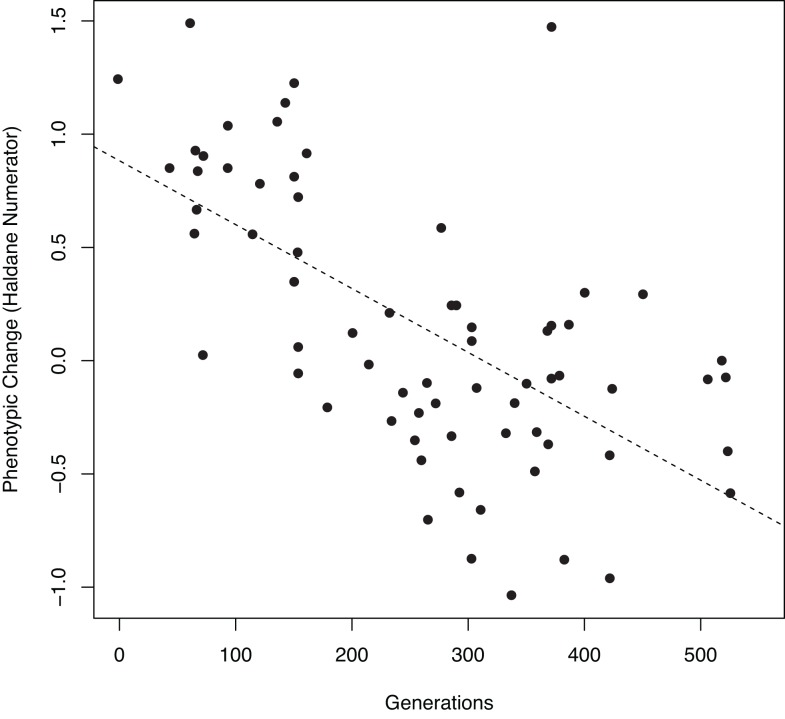
Evolutionary rates for Neolithic cattle, showing the Haldane numerator against time expressed in number of generations.